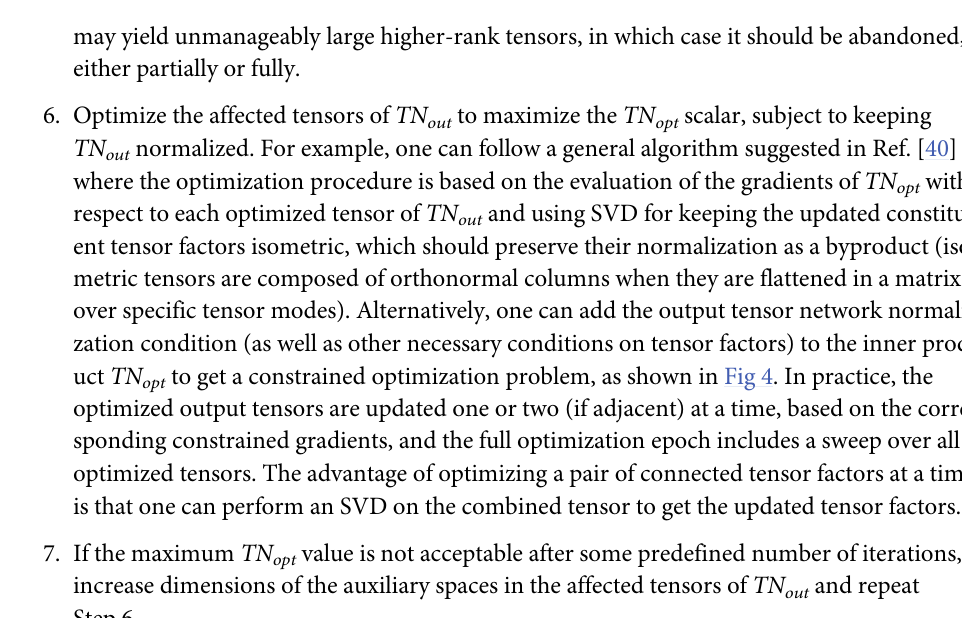
Fig 3. Graphical illustration of the simplification of the inner product being optimized: Some tensors that do not undergo an update can be contracted in order to reduce the total number of tensors while keeping memory requirements mostly intact.